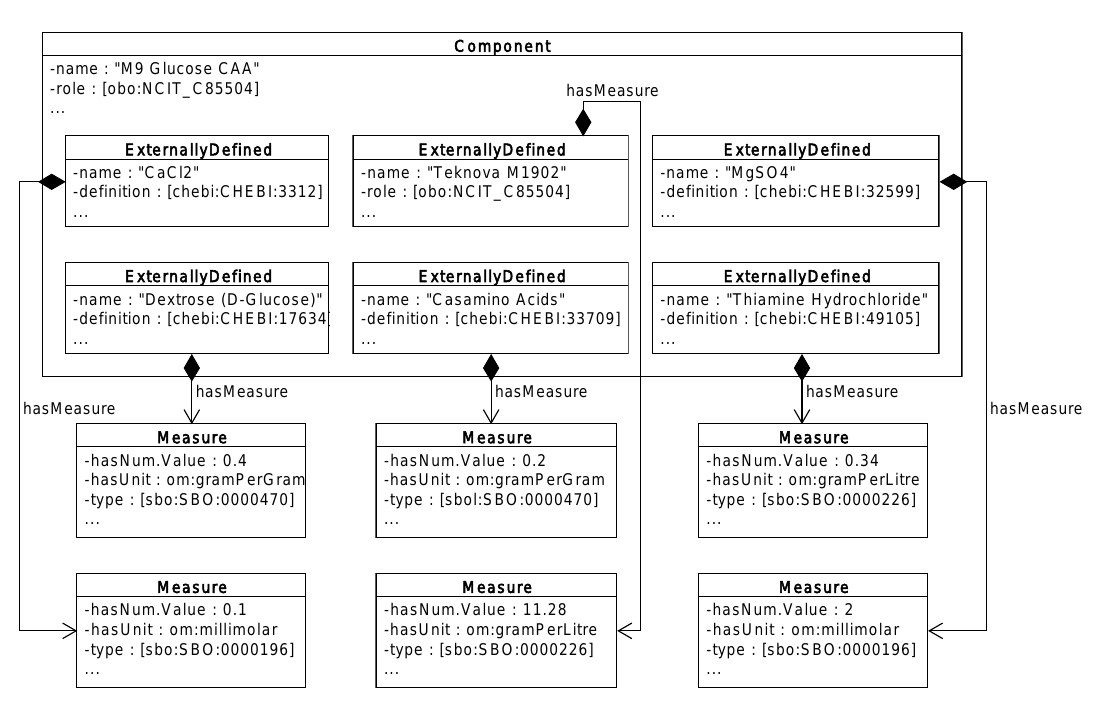
Section A Complementary